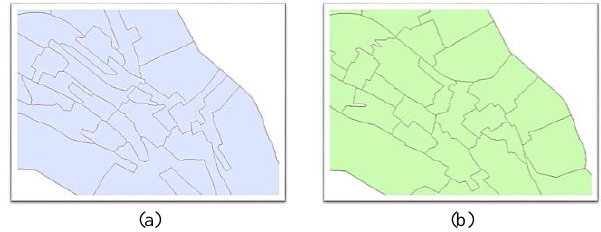
Figure 6. Comparison of the compactness for some districts